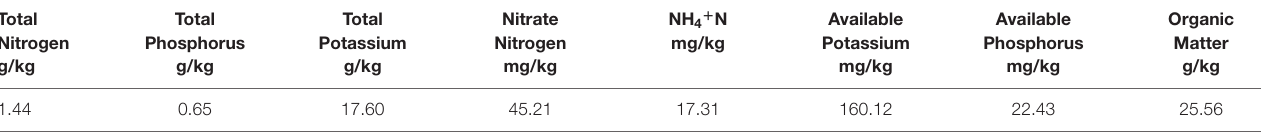
TABLE 1 | Base fertility of tested black